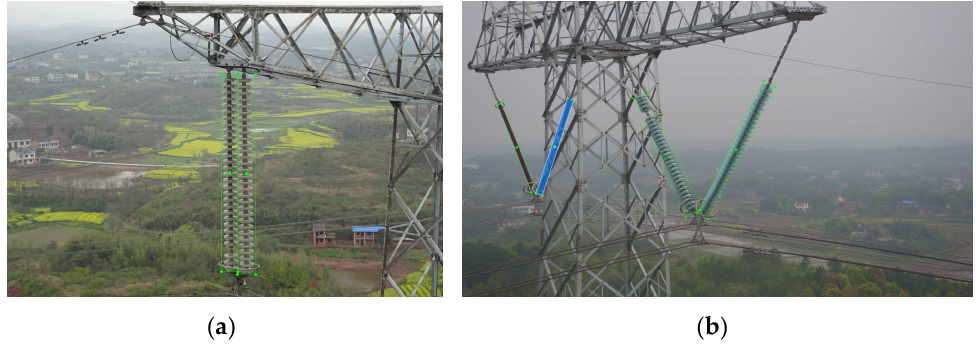
Figure 11. Object labeling of insulator strings: ( a ) rectangular box labeling; ( b ) rotating box label- ing.